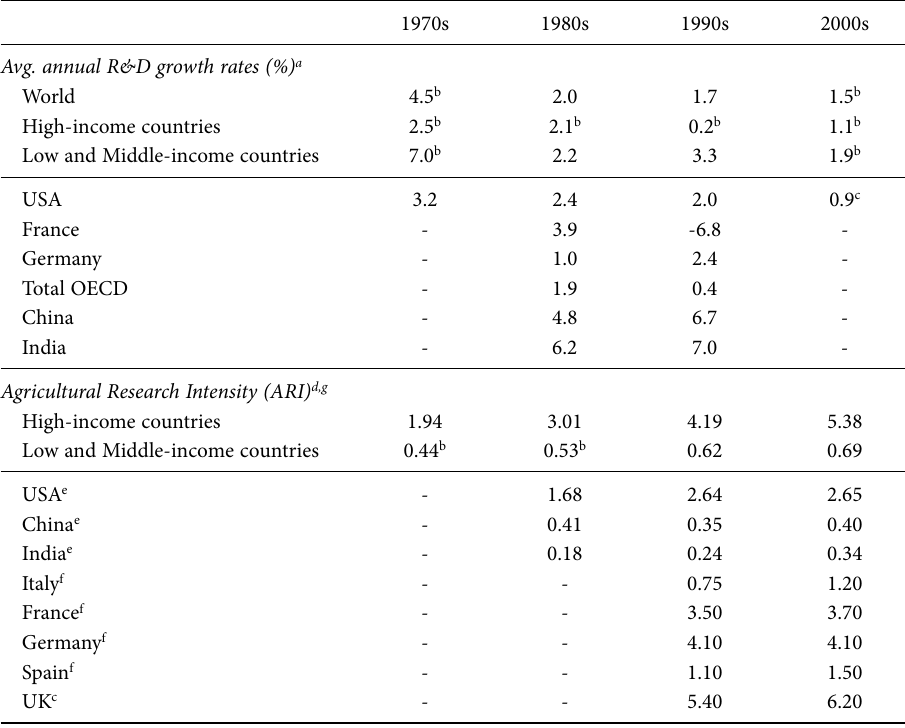
Table 3. Cross-country comparison of public agricultural research expenditure (in real terms) and of Agricultural Research Intensity (ARI) (public and private R&D),